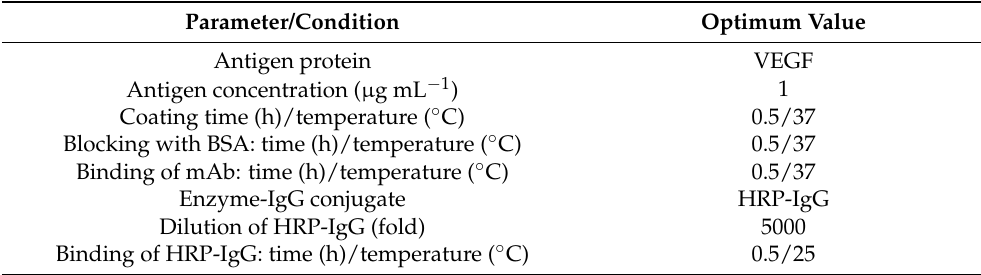
Table 1. A summary for the optimized parameters/conditions of the binding reactions used for development of the proposed CLEIA for BEV.